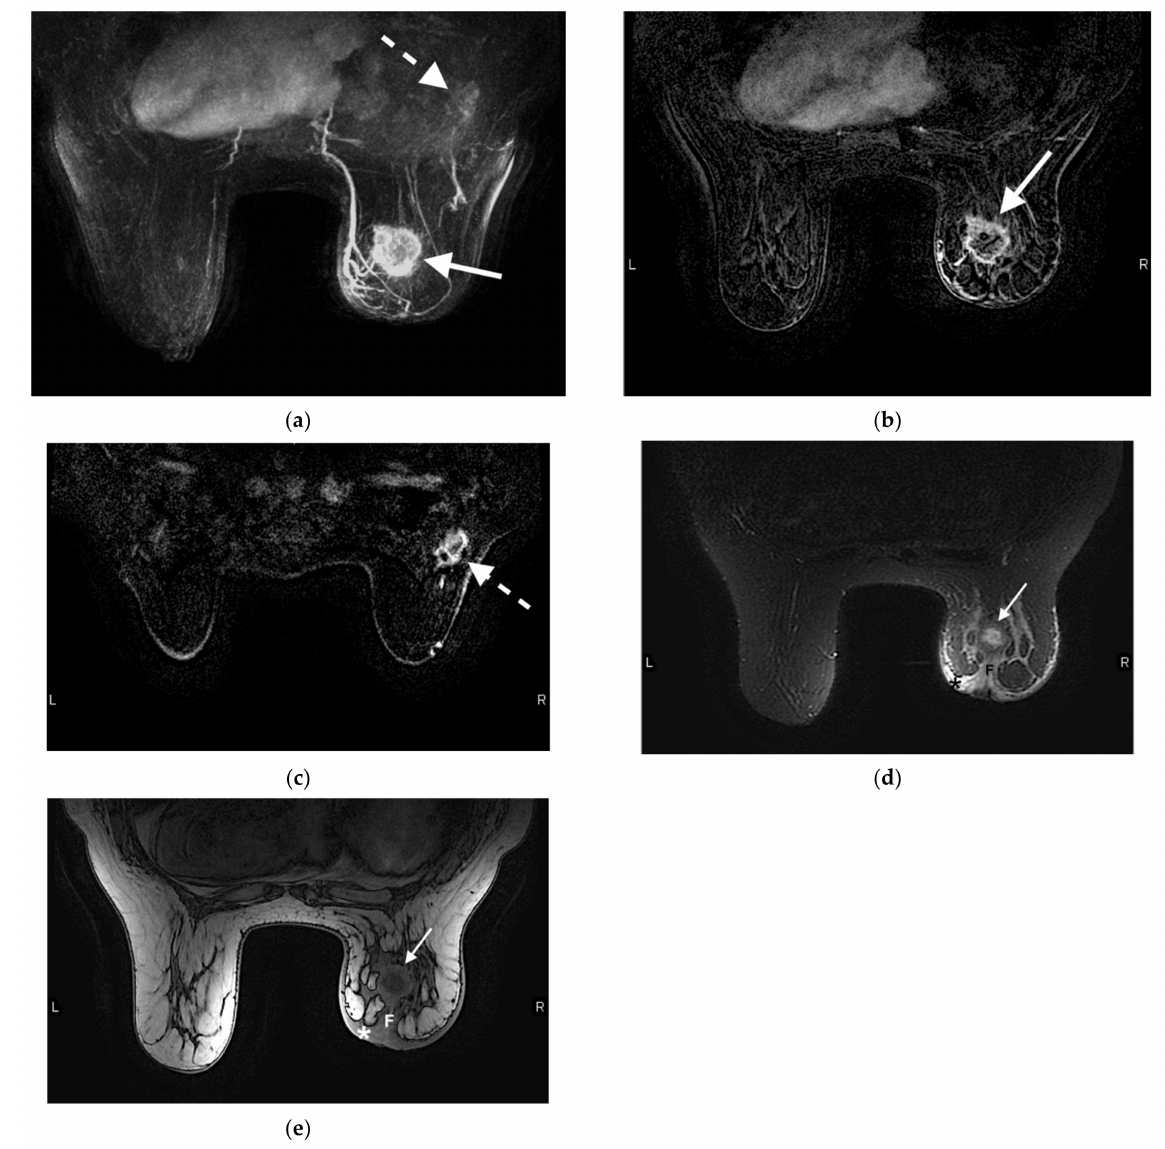
Figure 5. Example protocol of an abMRI. 61-year-old woman presented for screening MRI. ( a ) Maximum intensity projection image illustrates a 3.8 × 3.2 × 4.6 cm rim enhancing centrally necrotic mass in the right breast (arrow). Biopsy of this lesion yielded invasive ductal carcinoma. The enhancing axillary lymph nodes (dashed arrow) are asymmetric compared to the contralateral side, and was biopsy-proven metastatic disease. The right breast is asymmetrically decreased in size. ( b ) Contrast-enhanced axial T1-weighted fat-suppressed image demonstrates the same rim-enhancing mass in the right breast (arrow). ( c ) Contrast-enhanced axial T1-weighted fat-suppressed image demonstrates an irregular 2.8 × 2.0 cm spiculated mass, compatible with metastatic lymph nodes (dashed arrow). ( d ) Contrast-enhanced axial T2-weighted fat- suppressed image demonstrates the same right breast mass (arrow) with associated skin thickening (*), compatible with skin involvement. Associated fibrosis (F) results in nipple retraction, indicating nipple involvement. ( e ) Non-contrast-enhanced T1-weighted axial image without fat suppression redemonstrates the mass (arrow), skin thickening (*) and fibrosis (F) resulting in nipple retraction. In addition to the above sequences, a full protocol MRI would also include a T1-weighted axial noncontrast image with fat suppression, at least three other dynamic axial T1-weighted post-contrast sequences, and a sagittal delayed post-contrast